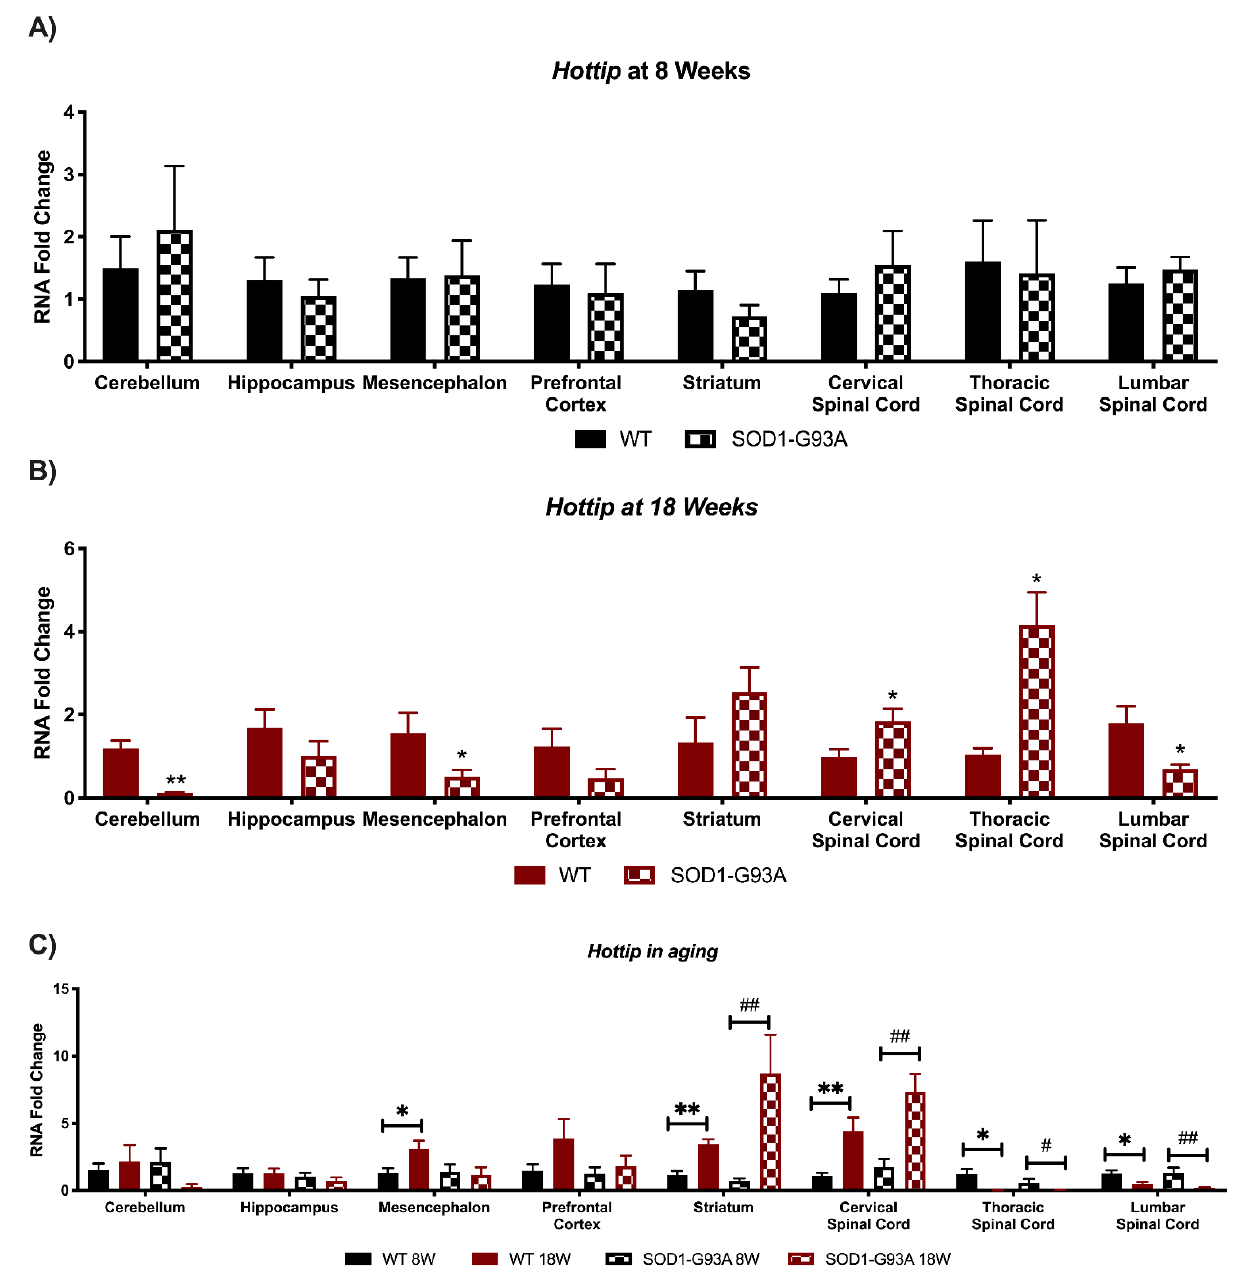
Figure 5. Alterations in Hottip expression in SOD1-G93A mice and during murine aging. RNAs expression levels were evaluated by Real Time-PCR in the different conditions. Data are expressed as mean ± SEM. ( A ) Hottip expression in 8 weeks old WT ( n = 6) mice versus 8 weeks old SOD1-G93A mice ( n = 6). ( B ) Hottip expression in 18 weeks old WT ( n = 6) mice versus 18 weeks old SOD1-G93A mice ( n = 6). * p < 0.05, ** p < 0.01 vs. WT. ( C ) Hottip expression in 8 weeks old WT mice versus 18 weeks old WT ( n = 6) and 8 weeks old SOD1-G93A mice versus 18 weeks old SOD1-G93A mice ( n = 6). * p < 0.05, ** p < 0.01 vs. WT 8W, # p < 0.05, ## p < 0.01 vs. SOD1-G93A 8W.